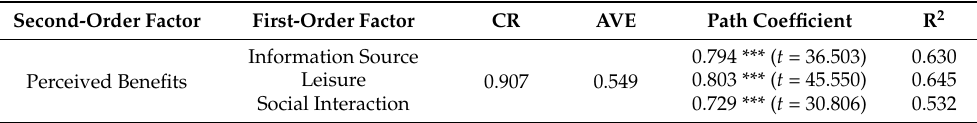
Table 5. Assessment of the higher-order factor model.